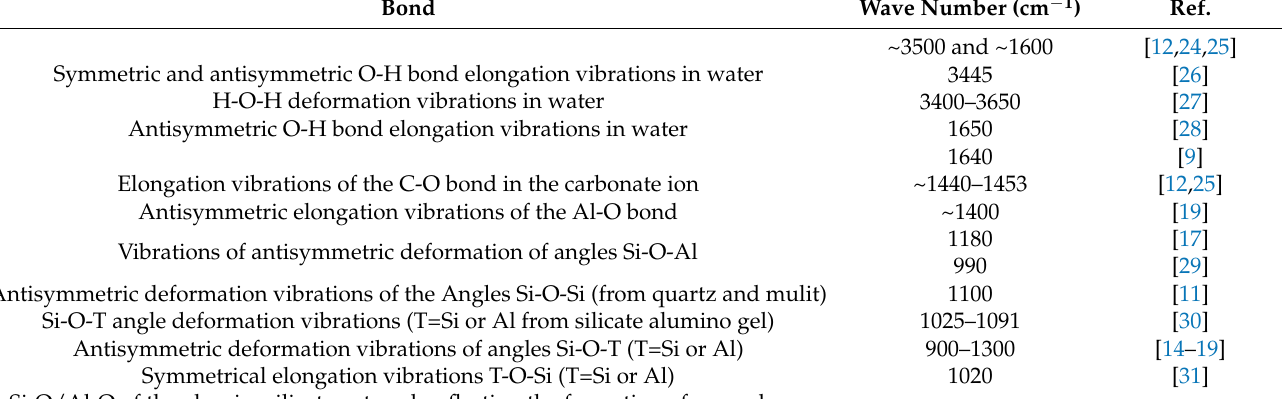
Table 1. Assignment of IR bands from the geopolymer structure according to the specialized literature.